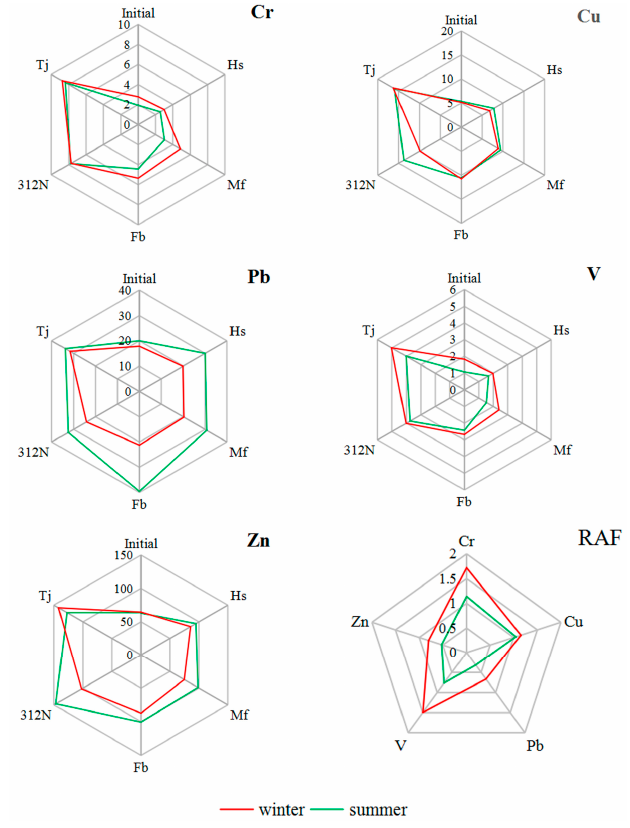
Figure 3. Seasonal variation in metal concentrations (mg · kg − 1 ) in the moss S. junghuhnianum exposed to air in bags for 6 weeks at five monitoring sites as indicated by the average relative accumulation factor （ RAF ） for each metal in winter and summer.